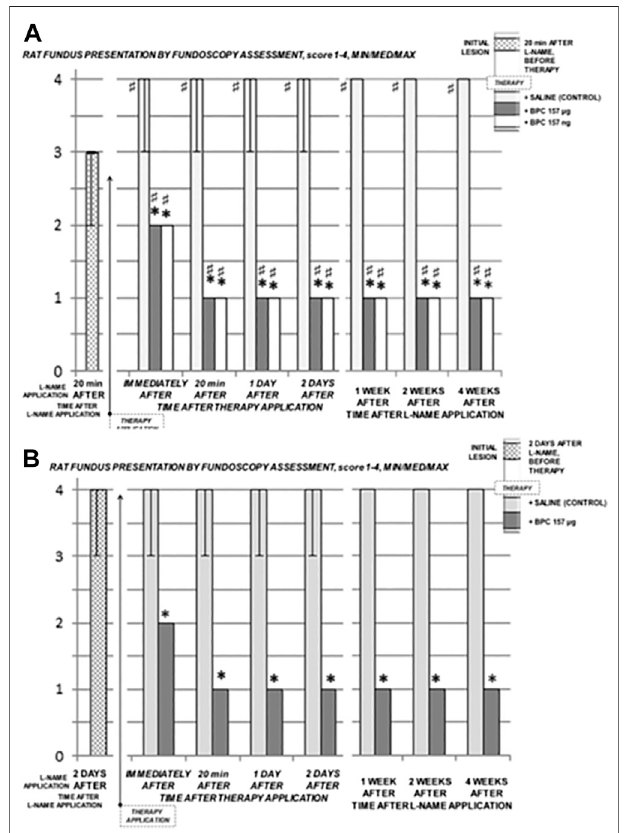
FIGURE 5 | Retrobulbar L-NAME application – induced retinal damage as fundus assessment by fundoscopy. L-NAME retrobulbar application (total dose 5 mg/kg, which was divided by retrobulbar application in each eye, 0.5 mg/0.1 ml saline/eye). Rats underwent L-NAME that received BPC 157 therapy (total dose 10 μ g/kg or 10 ng/kg as retrobulbar application in each eye, 1 μ g/0.1 ml saline/eye or 1 ng/0.1 ml saline/eye) at 20 min (A) or at 2 days (B) (BPC 157 μ g, BPC 157 ng). Quick demonstration of preserved fundus presentation. Rats underwent L-NAME that received saline as therapy [saline only as a retrobulbar application in each eye (0.1 ml/eye)] (+SALINE). Severely damaged fundus presentation. * p < 0.05, at least vs. control; Y p < 0.05,atleastvs.initialvalues.10ratsperexperimentalgroupandperiodfor all experiments.